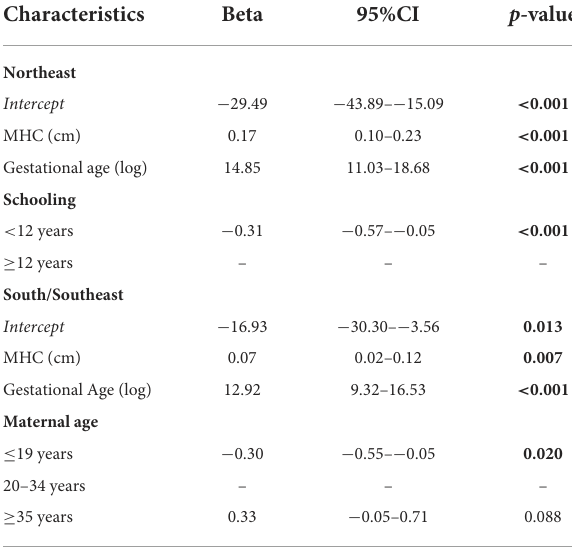
TABLE 2 Multiple linear regression analysis of explanatory factors for the association between